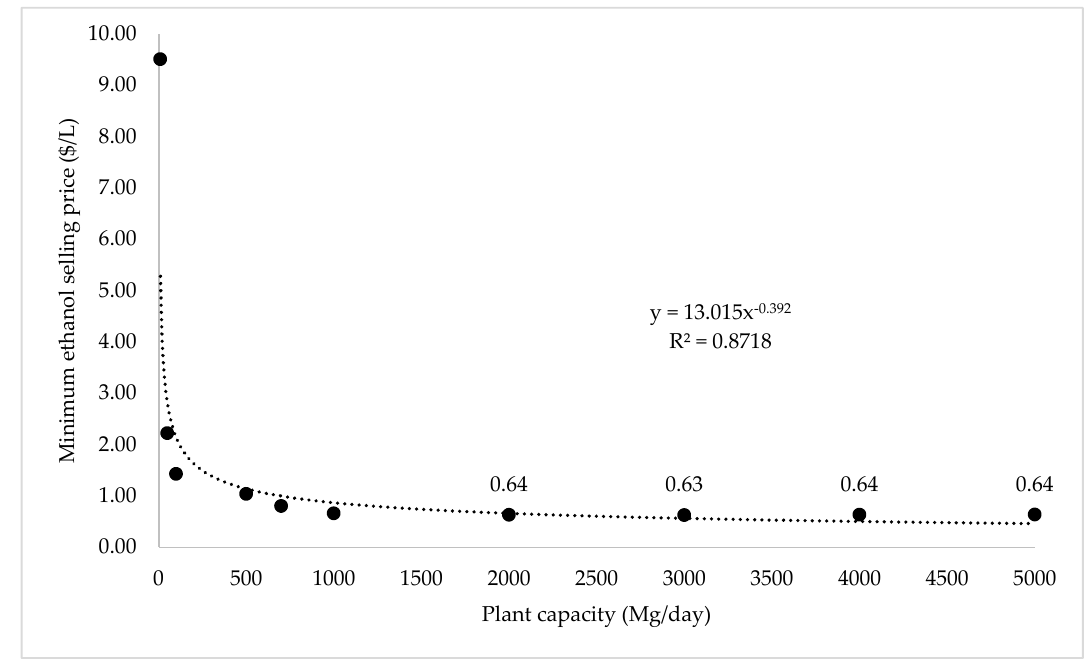
Figure 10. Economies of scale for the scenario B FW fermentation process, without enzymes and a 2-step distillation system.